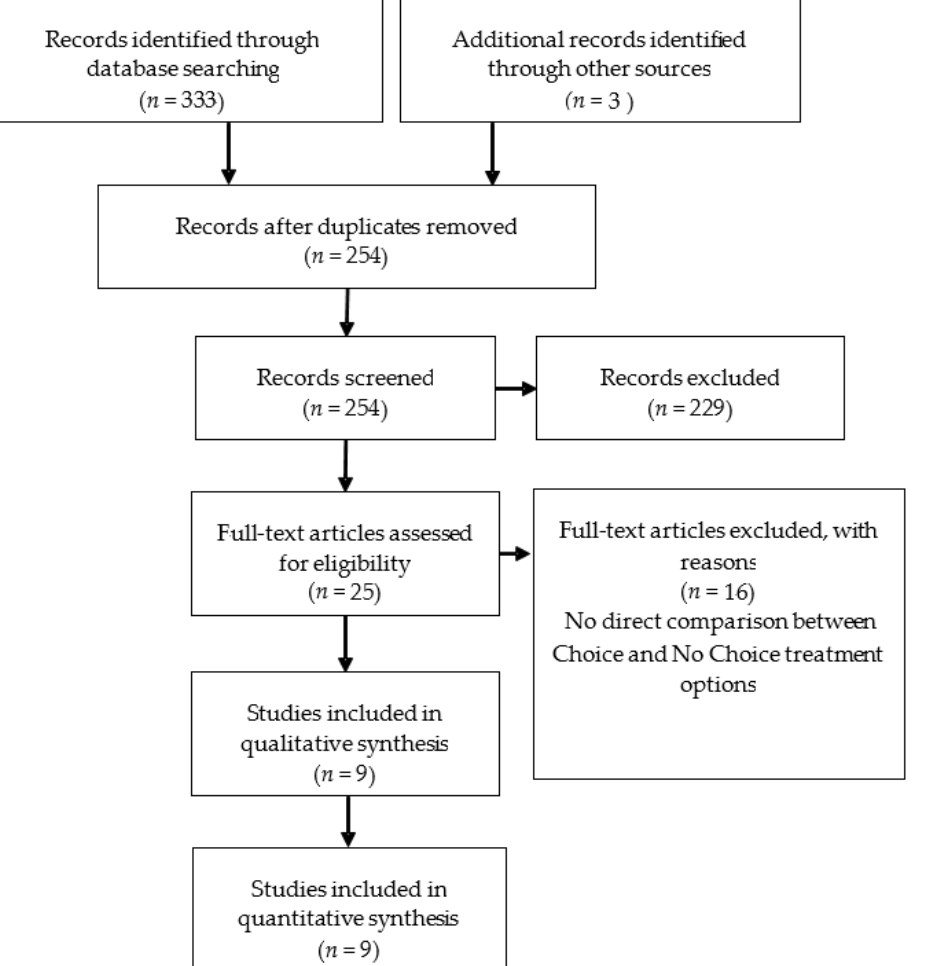
Figure 1. PRISMA (Preferred Reporting Items for Systematic Reviews and Meta-Analyses) flow diagram of study selection.